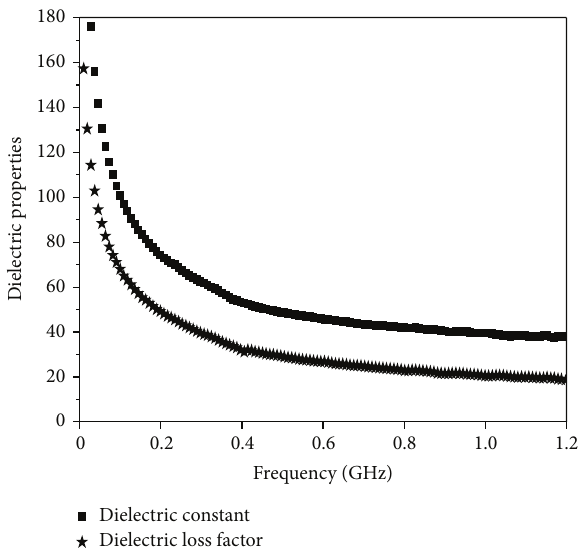
Figure 5: Dielectric properties versus frequency of Zn/Al-NO 3 .